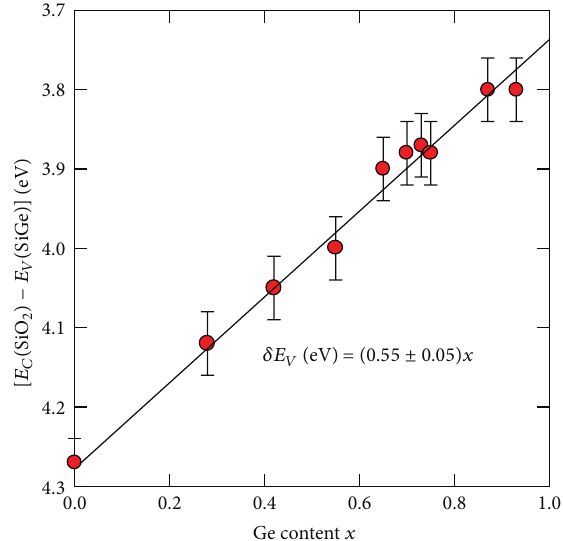
Figure 21: Energy barrier between the VB top of Si 1−𝑥 Ge 𝑥 layers and the bottom of the SiO 2 CB as a function of Ge content in the semiconductor.